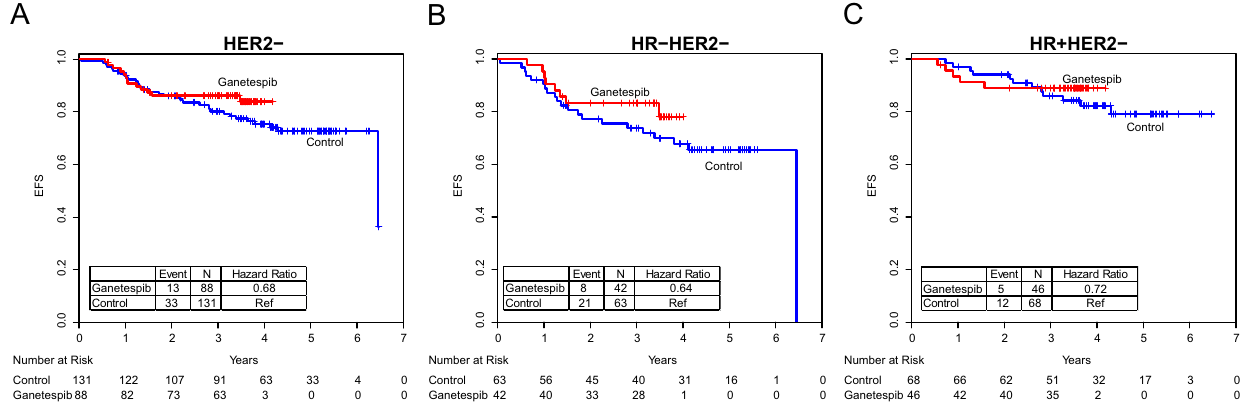
Fig. 3 Event-free survival. Kaplan – Meier plots of event-free survival comparing ganetespib and control arms in A all HER2-negative participants, B triple negative participants, and C HR-positive/HER2-negative participants. Median follow-up in the overall (HER2-negative) population was 3.6